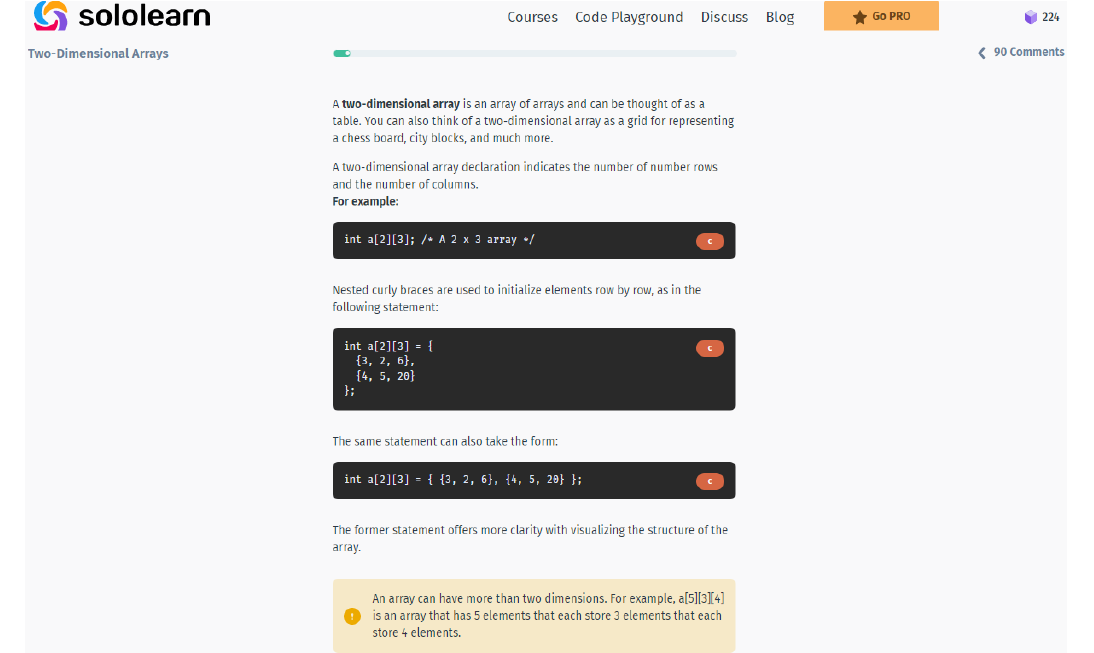
Figure 2: Theoretical material in the MOOC